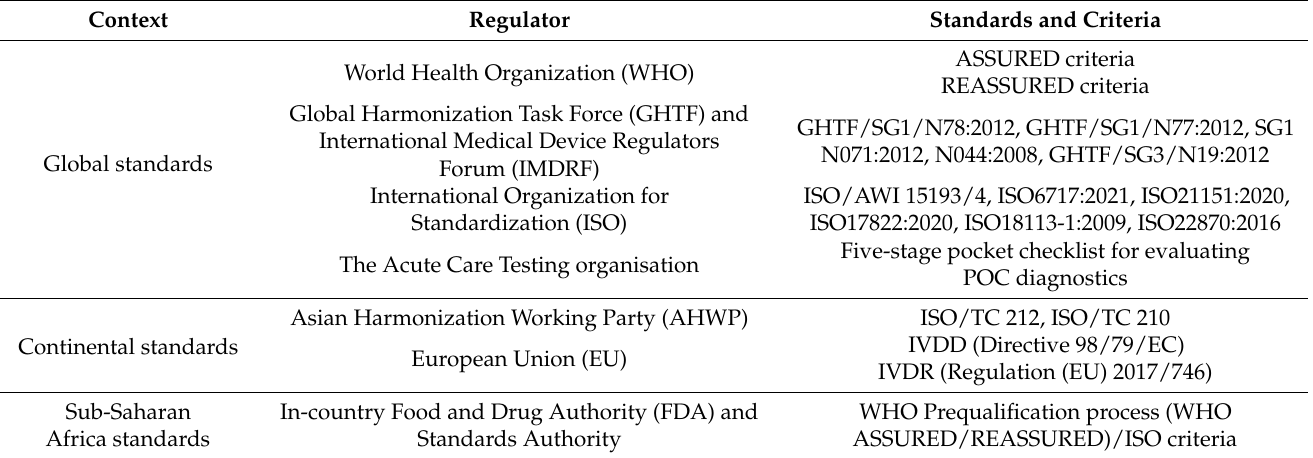
Table 1. Standards for clinical